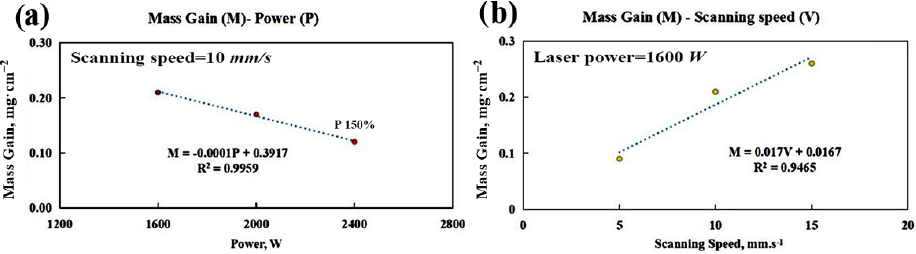
Figure 14. Linear regression equation of mass gain and process parameters; power ( a ), and scanning speed ( b ).